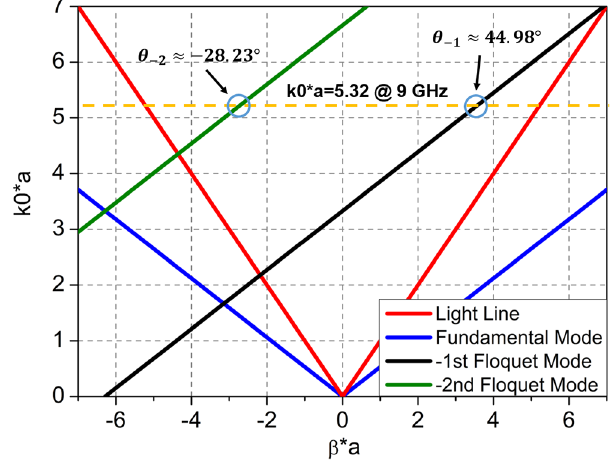
Fig. 5. Dispersion diagram of the proposed antenna based on (1) when X 0 is set